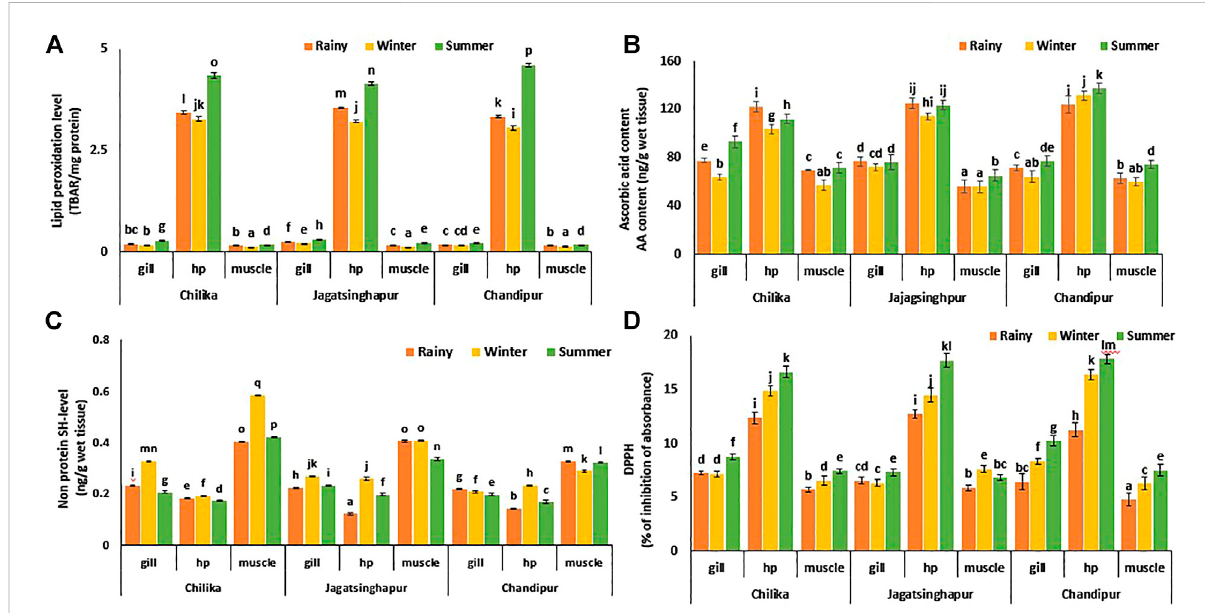
FIGURE 2 Spatiotemporalvariation oftissue-speci fi coxidativestress,smallantioxidantlevel,andtotalantioxidantparameter in Scyllaserrata. (A) Ascorbic acid level, (B) GSH level, (C) DPPH scavenging activity, the levels of biotransformation enzyme, and (D) Lipid peroxidation level of S. serrata . Data are presented as the mean ± S.D. (n = 10). MANOVA followed to compare the means. Different letters above the bars denote the statistical differences between mean values at p <